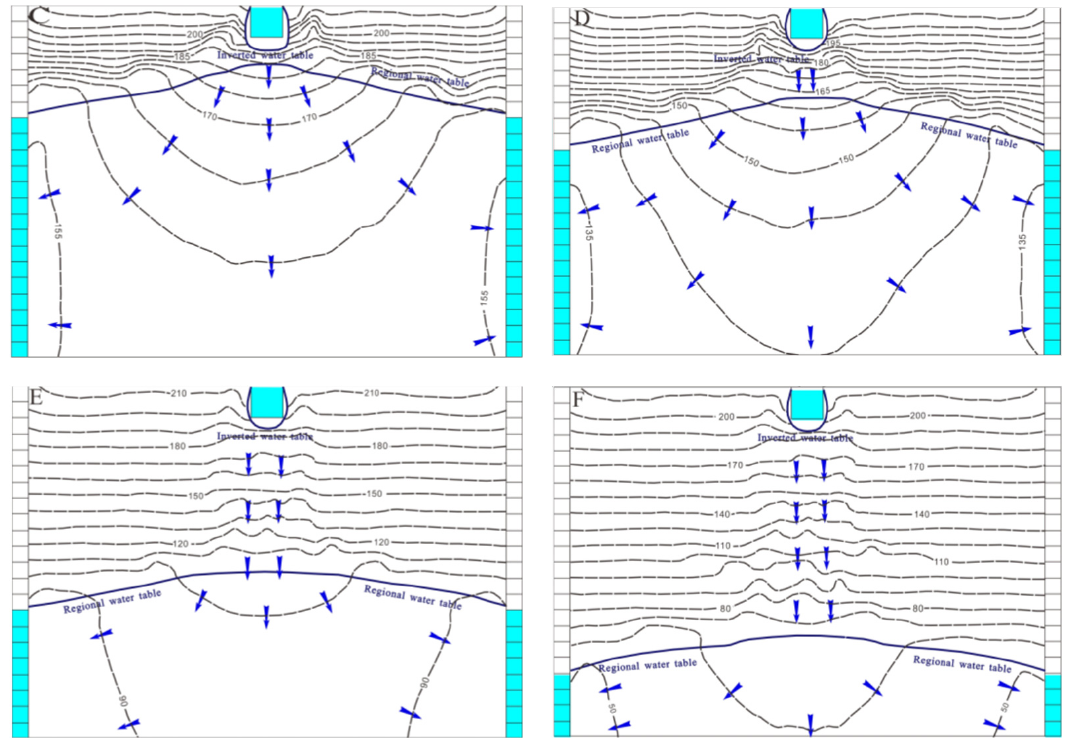
Figure 6. The change in the relationship between river water and groundwater in the sandbox experiment under the water-bearing medium sand B and a river water depth of 18.5 cm. Discharge water level ( A ): 200 cm, ( B ): 160 cm, ( C ): 150 cm, ( D ): 130 cm, ( E ): 80 c m, and ( F ): 40 cm.